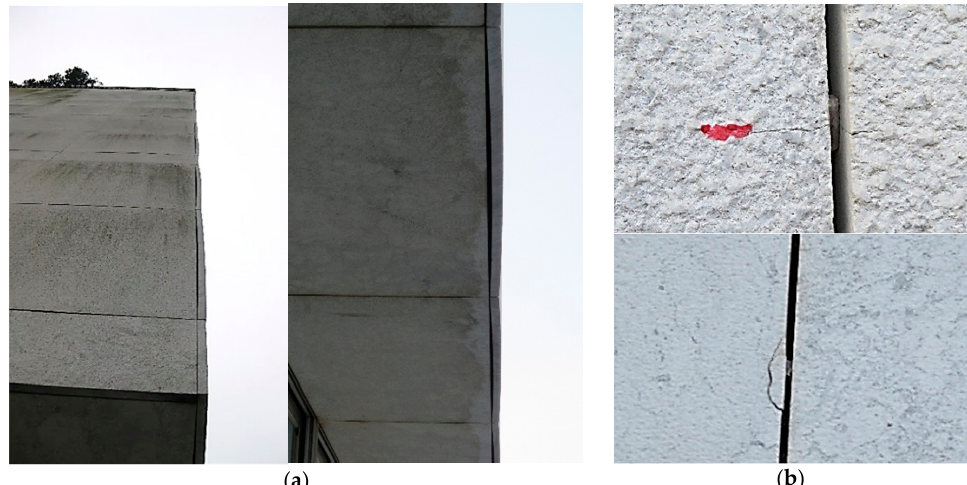
Figure 3. Examples of bowing and damage detected on the marble cladding: ( a ) bowing of slabs in the east and west façades; ( b ) local damage/fracture near the fixing points of the slabs .